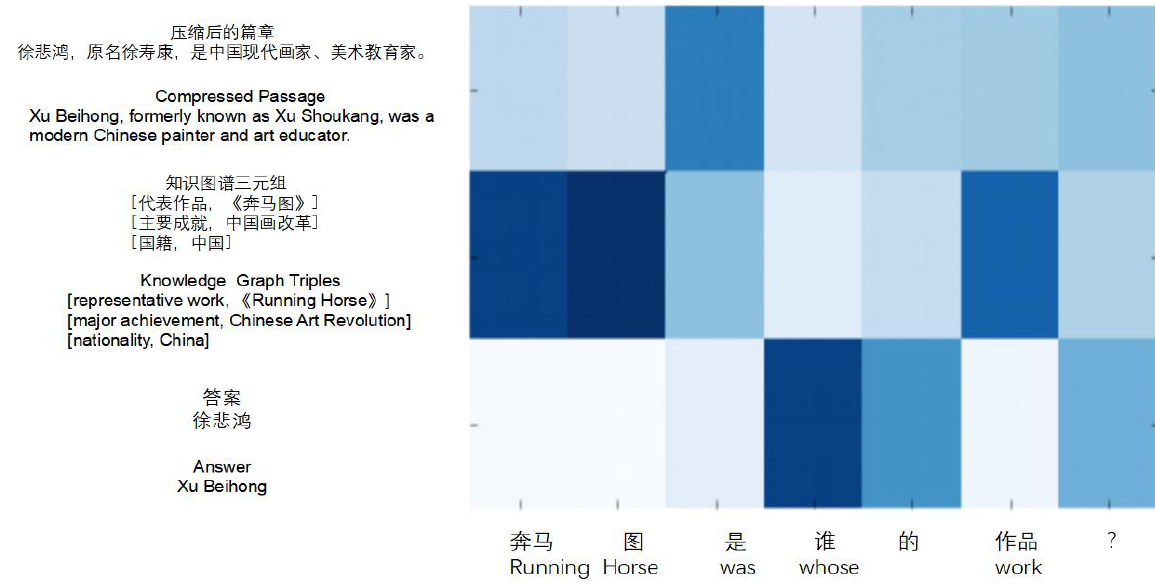
Figure 5. Global attention distribution when NQGKG++ generated question Q6.